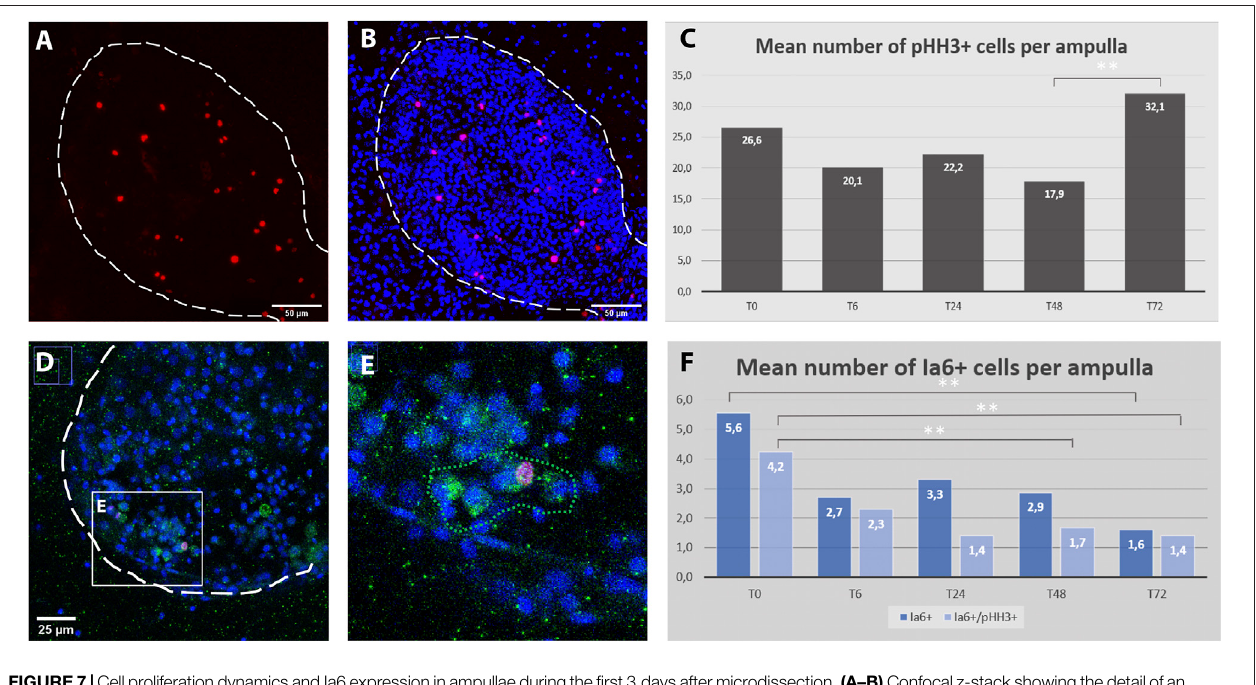
FIGURE7| CellproliferationdynamicsandIa6expressioninampullaeduringthe fi rst3 daysaftermicrodissection. (A – B) Confocalz-stackshowingthedetailofan ampulla: proliferating cells are stained with anti-phospho-HH3 (red), cell nuclei are counter-stained with Hoechst (blue), ampulla shape is outlined with dotted lines. (C) AveragenumberofpHH3+cellsperampullafor fi vetime-pointswithinthe fi rst3 daysaftermicrodissection.Asigni fi cantdifferencehasbeendetectedonlybetween48 h (T48)and72(T72)hourspostmicrodissection( p =0.025). (D – E) ampullacontainingaclusterofIa6+cells(green)includingoneco-labeledwithanti-phospho-HH3 (red). (F) Histogram showing the proportion of proliferation Ia6+ cells and their dynamic within the fi rst 3 days after microdissection ( p =